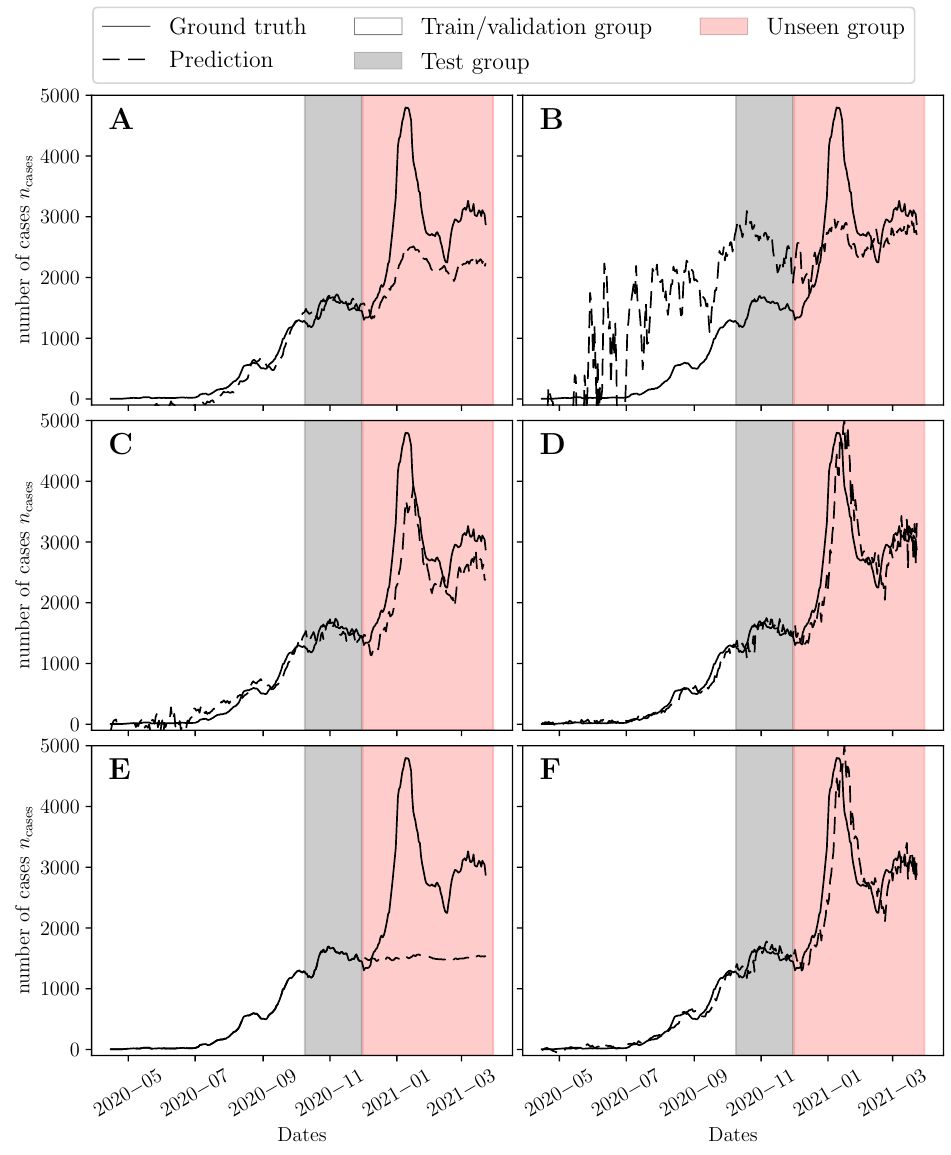
Figure 6. Predicted 7-day rolling average of daily number of cases on the unseen data set using ( A ) the sequence-to-sequence (S2S) model, ( B ) the stacked LSTM (SEQ), ( C ) The feedforward neural network (DNN), ( D ) The support vector machine regression (SVR) model, ( E ) The gradient boosting machine (GBM), and ( F ) the polynomial regression (OLS) model. All models were tuned using the validation error of the discovery set. The grey shaded region represents the test data set (Group 2) used to test the models’ performance. The models were retrained using both the discovery and test data sets and subsequently used to infer the number of cases in the unseen data set (the red shaded